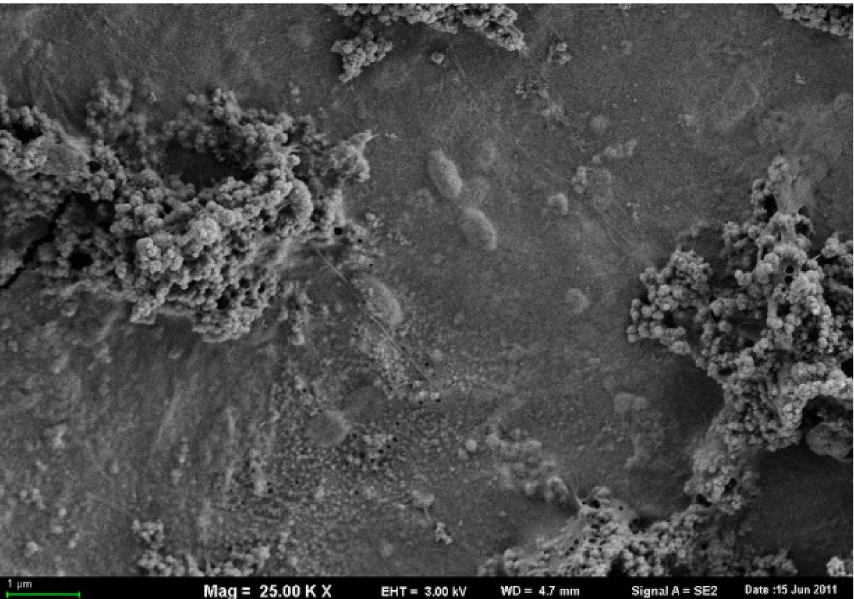
Figure 3. Scanning electron micrograph ( × 25,000 magnification) of bacterial cells in a biofilm (im- mersed in the extracellular polymeric substance matrix) on the surface of a high-density polyethylene pipe in a model drinking water distribution system (from Rozej et al. [81], distributed under the terms of the Creative Commons CC BY